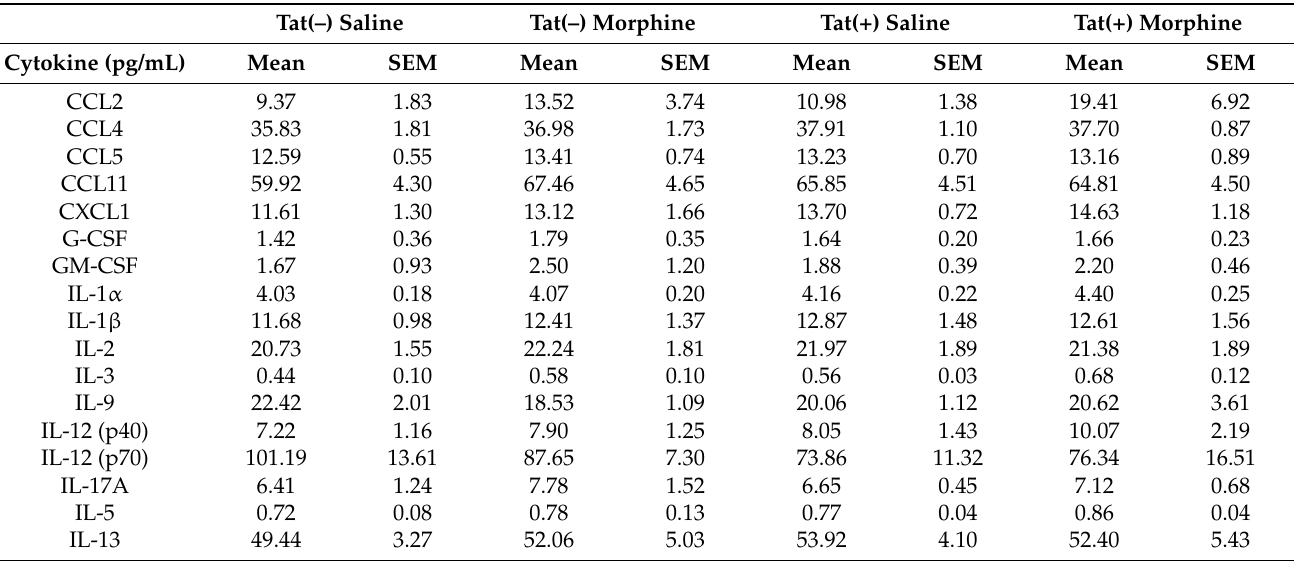
Table 2. Means ± SEM of chemokines and cytokines not significantly altered by Tat or morphine in this